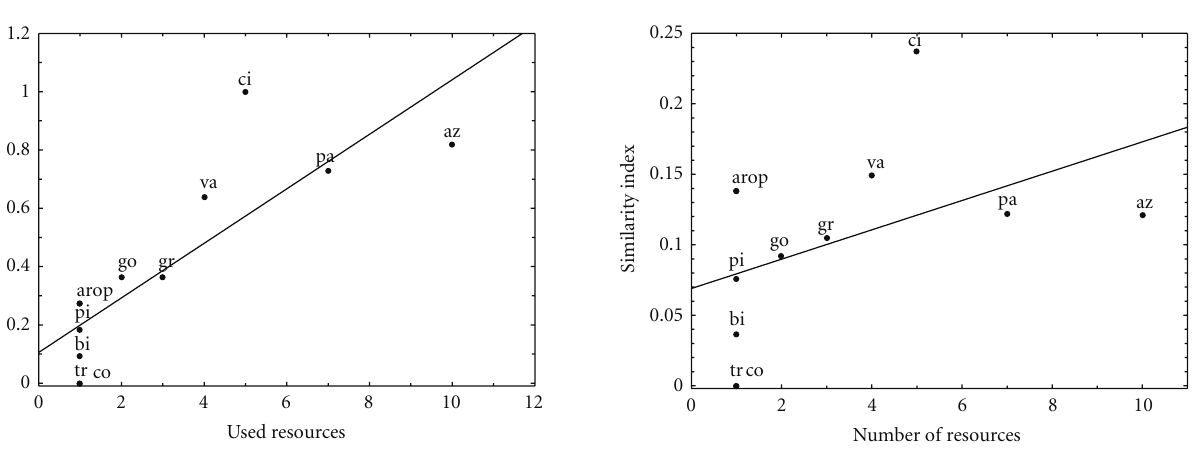
Figure 4: Relationship between the total number of plant resources used by each Merosargus species and the average Jaccard similarity index for each species from samples collected at the Parque Estadual do Rio Doce (PERD), Minas Gerais, Brazil, between October 2001 and October 2004. ar- M. arcuatus ; az- M. azureus ; bi- M. bivittatus ; ci- M. cingulatus ; co- M. coxalis ; go- M. gowdeyi ; gr- M. gracilis ; op- M. opaliger ; pa- M. pallifrons ; pi- M. pictipes ; tr- M. transversus ; va- M. varicrus